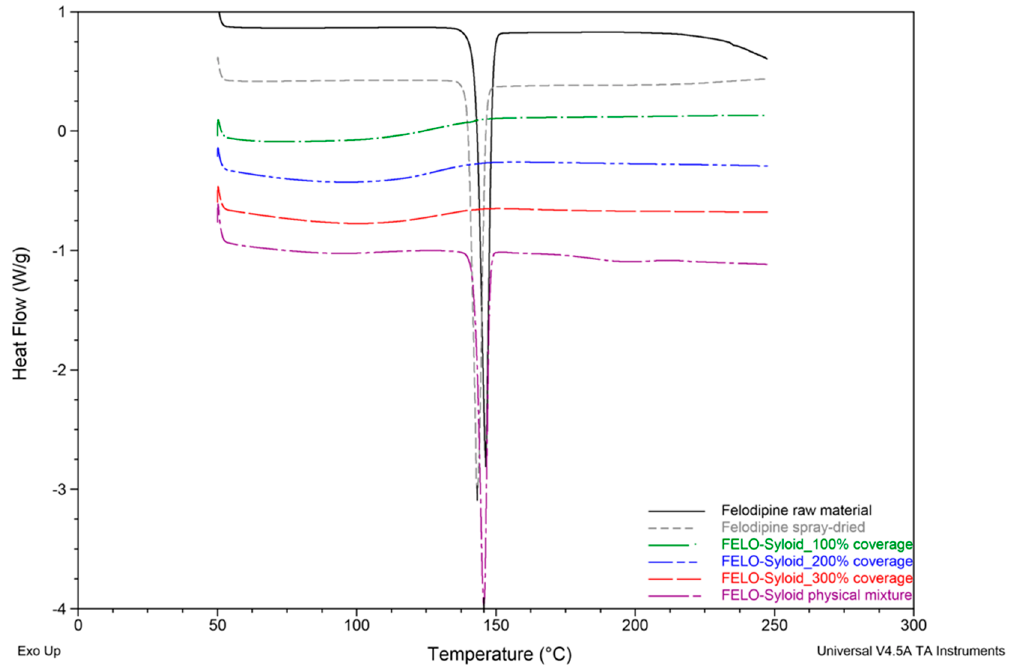
Figure 2. Differential Scanning Calorimetry (DSC) thermograms of Felodipine raw and spray-dried materials, Felodipine (FELO)-Syloid formulations at various drug loads, FELO-Syloid physical mixture. Sharp endothermic peaks at 222.8 ± 0.8 °C and 223.9 ± 0.3 °C were observed in DSC curves of